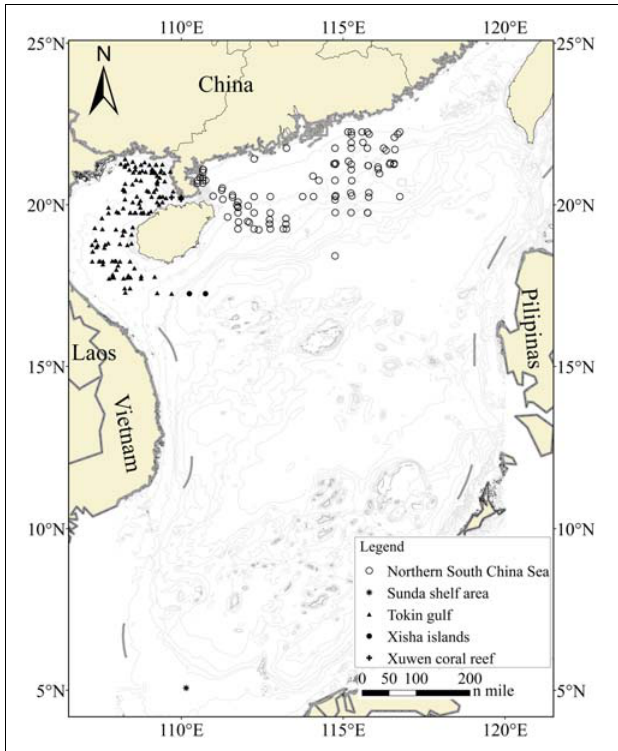
FIGURE 1 | Sampling locations for fish larvae from five areas. Each station yielded one or more samples, and the stations that failed to obtain larval COI sequences were not